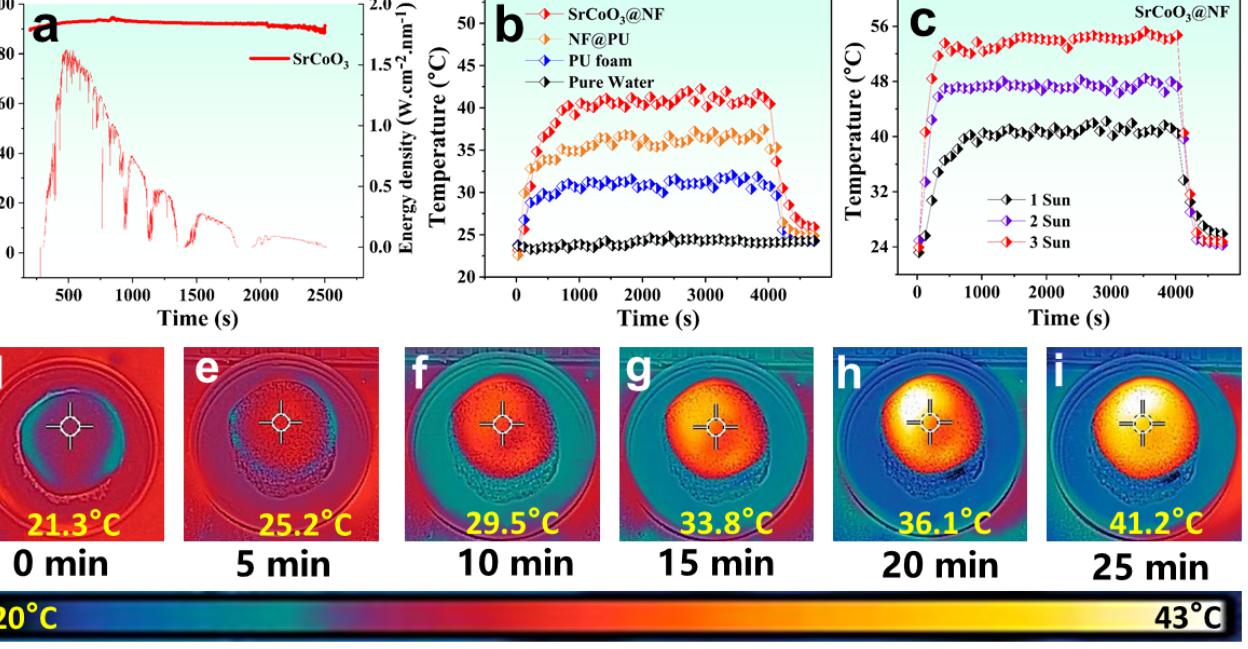
Figure 4. ( a ) UV-Vis absorption spectrum of SrCoO 3 over wide range (200–2500 nm). ( b ) Surface temperature changes for pure water, PU foam, NF@PU, and SrCoO 3 @NF under 1 kW m − 2 . ( c ) Surface temperature enhancement of SrCoO 3 @NF solar evaporator under di ff erent solar intensities. ( d – i ) Time-dependent IR images of SrCoO 3 @NF under 1 sun illumination.